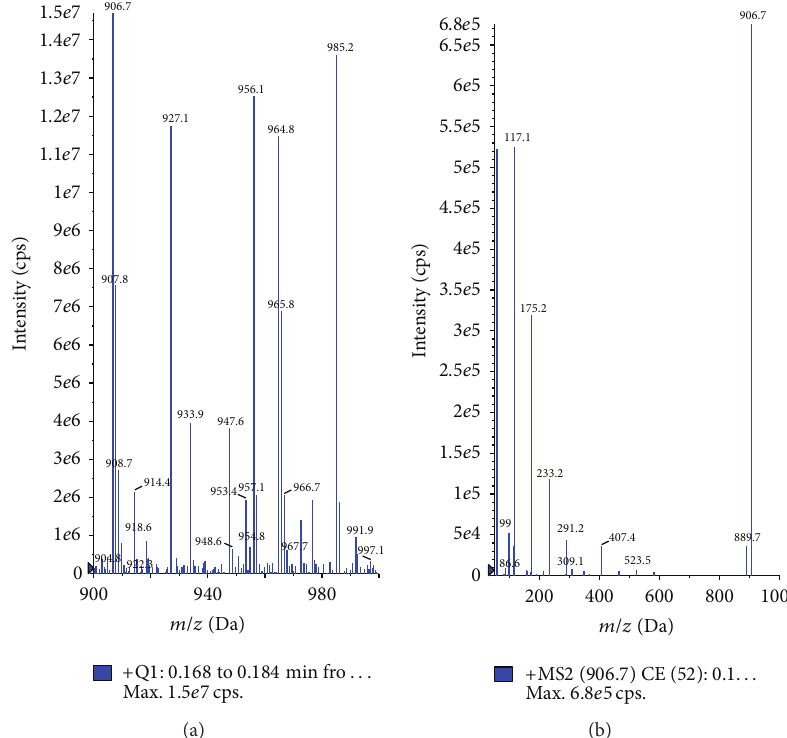
Figure 5: (a) Parent ion scan representing the molecular ions of PPG. (b) Fragmentation pattern for molecular ion of PPG with m/z 906.70.